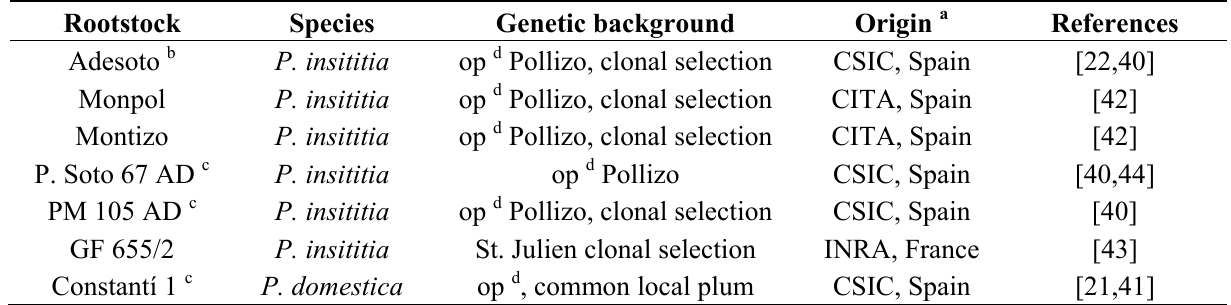
Table 7. List of studied rootstocks, description and